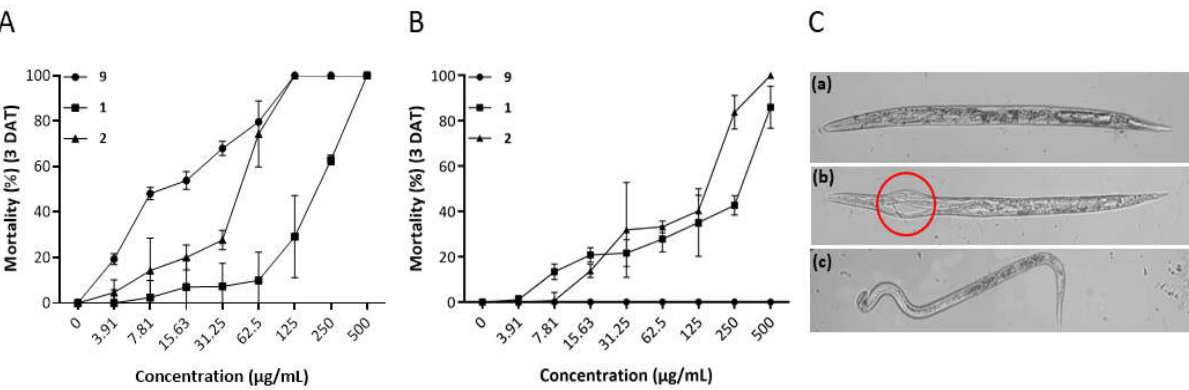
Molecules 2021 , 26 , x FOR PEER REVIEW Figure 2. Biosynthesis of grammicin, an isomer of patulin, and its intermediates used in this study (adapted from [16]).